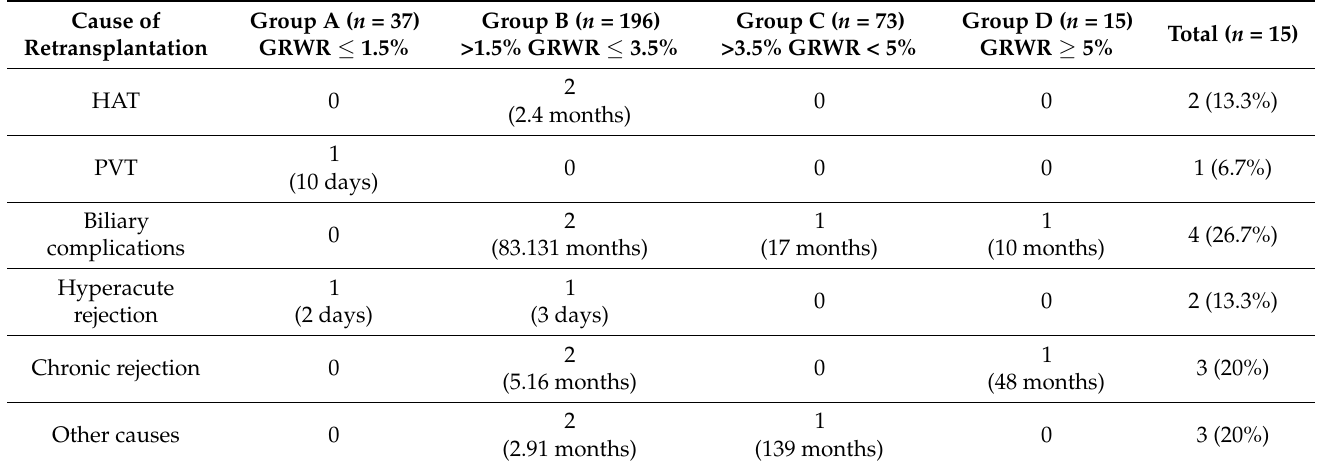
Table 6. Causes and time (days or months) of